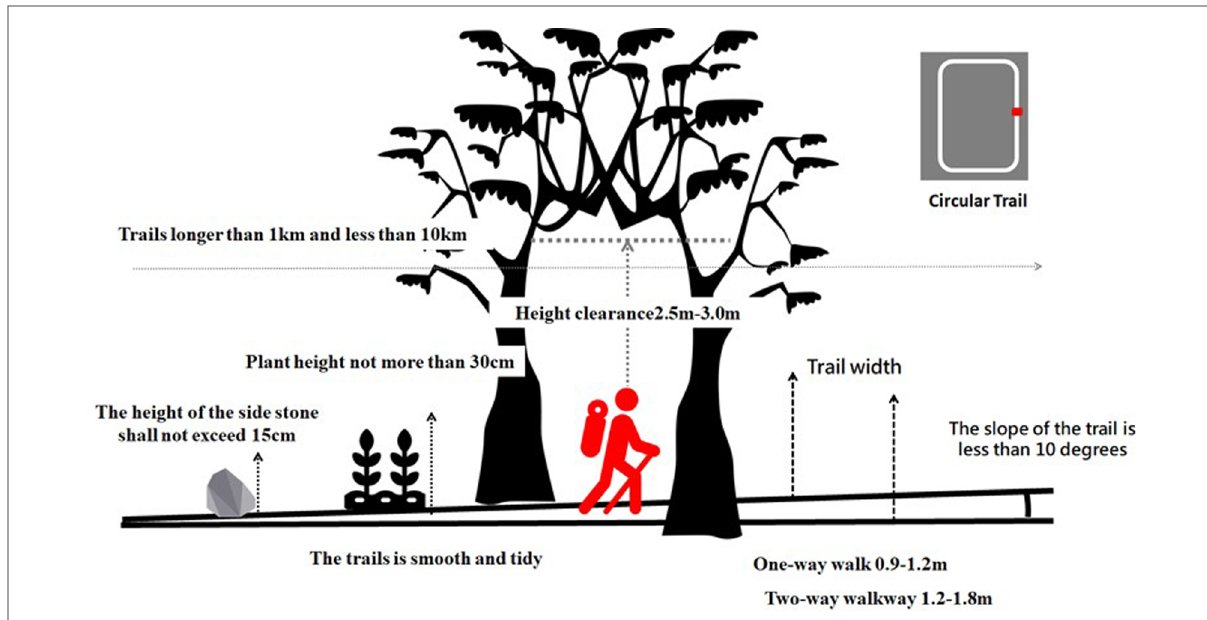
FIGURE 1 Favorable outdoor trail environment